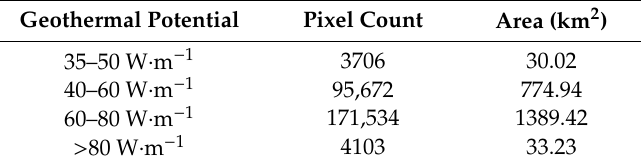
Figure 11. Geothermal potential map ( a ) and ground truth ( b ). Table 4. Surface occupied by each geothermal potential class.